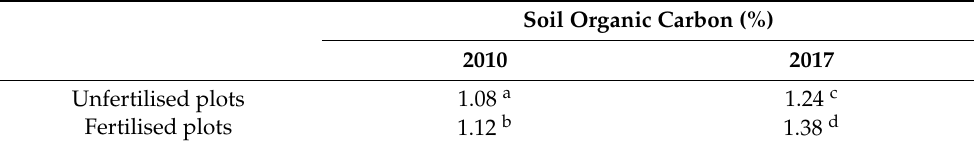
Table 5. Soil organic carbon content (%) in 2010 and 2017 (means sharing a letter are not significantly different, p < 0.001).